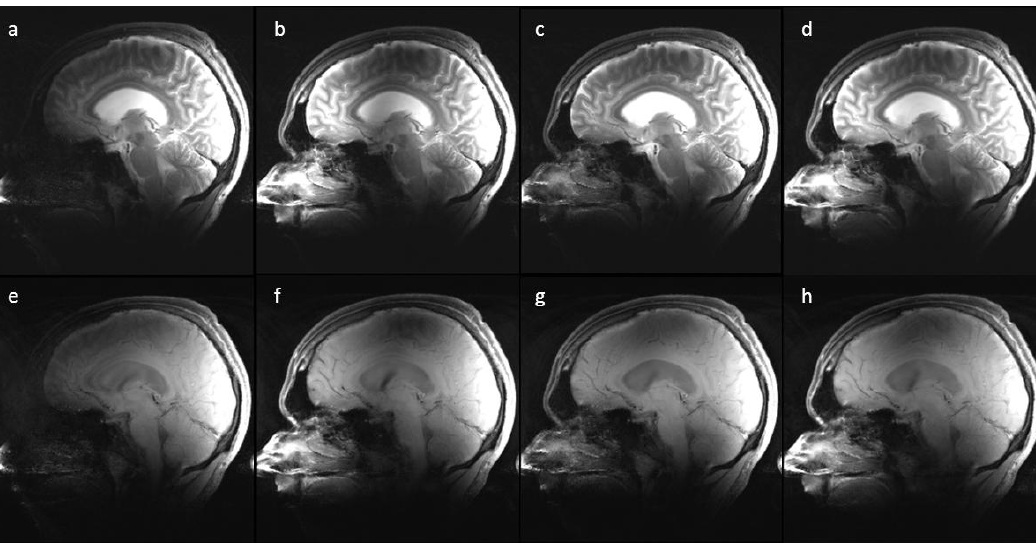
Figure 4. ( a – d ) T2w Turbo-Spin-Echo (TSE) and ( e – h ) T1w SE images, acquired by performing static RF shimming with 1-, 2-, 4- and 8-channel Tx configurations respectively.